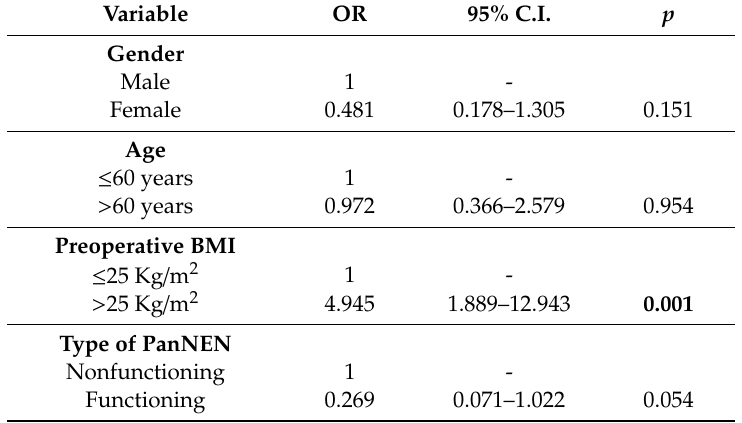
Table 3. Multivariate logistic regression analysis of predictors of postoperative diabetes mellitus (DM). Variable OR 95%